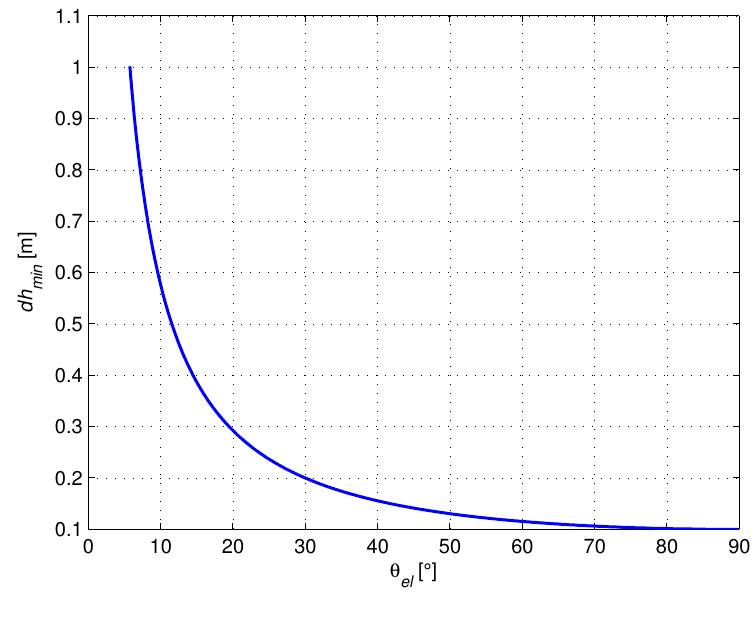
Figure 3. Antenna variation as a function of the satellite